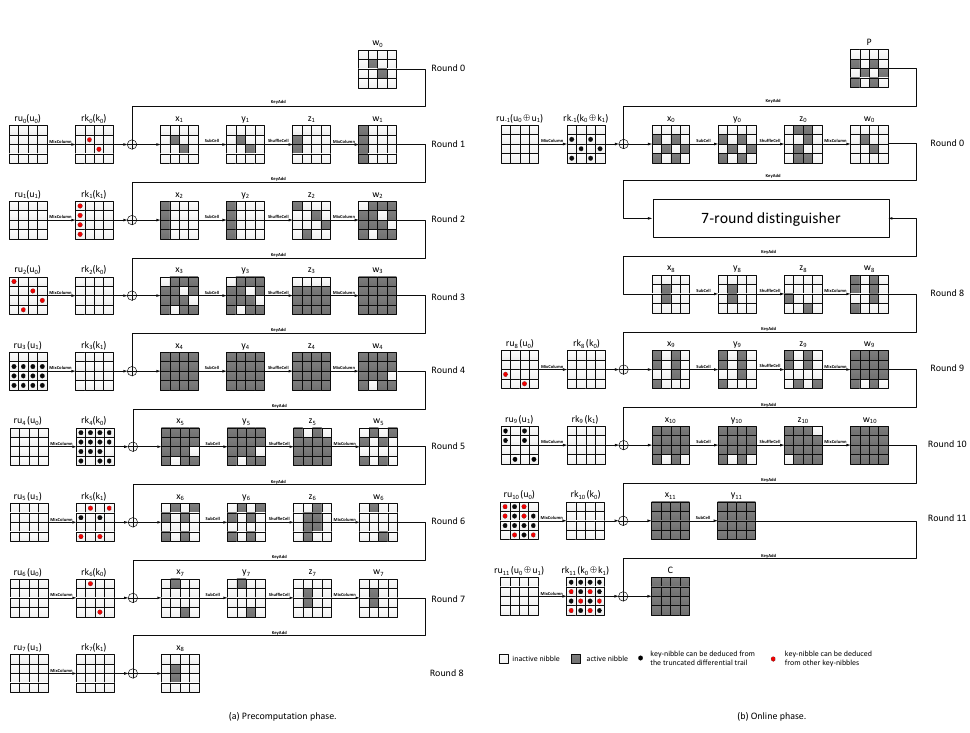
Figure 16: The attack on 12-round Midori64. The 7-round distinguisher is shown in (a), the online phase is shown in